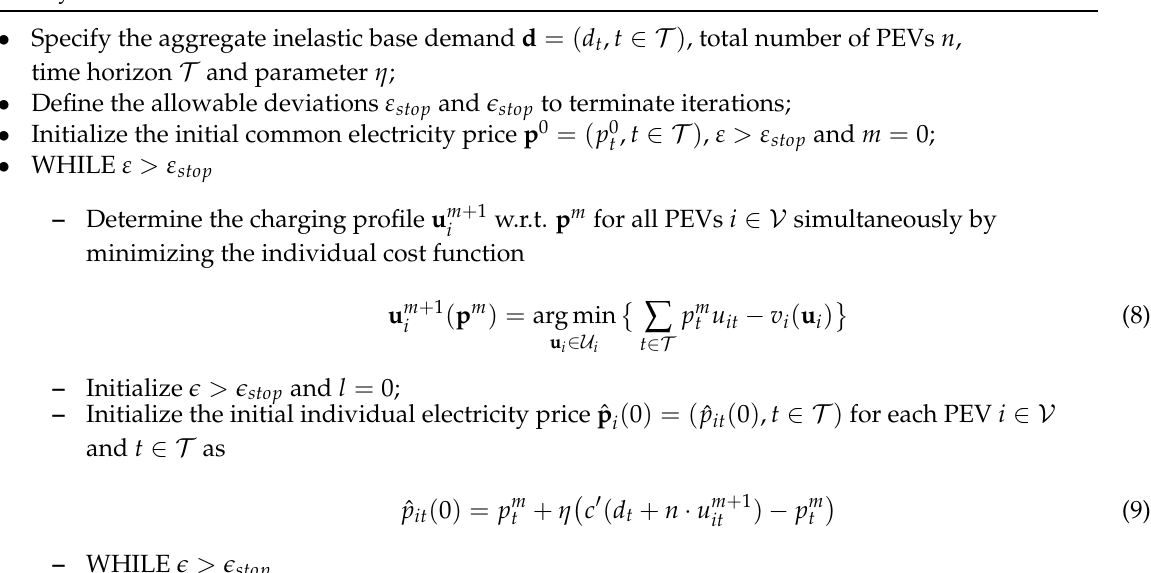
Algorithm 1: Distributed coordination of PEV charging without the consideration of